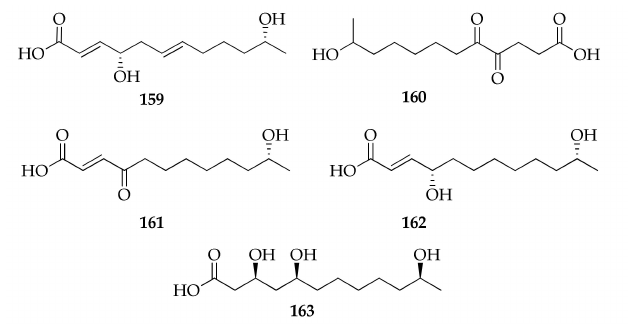
Figure 25. Structures of seco acids.